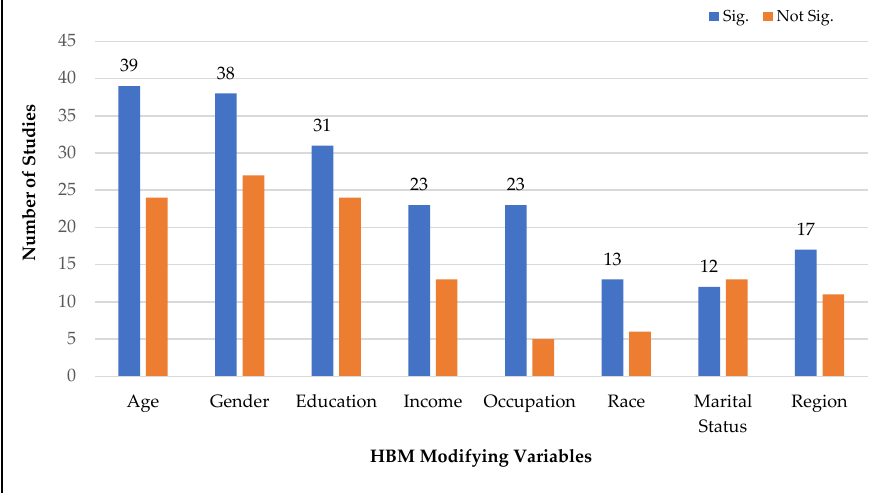
Figure 4. Health belief model constructs predicting booster vaccination intention.